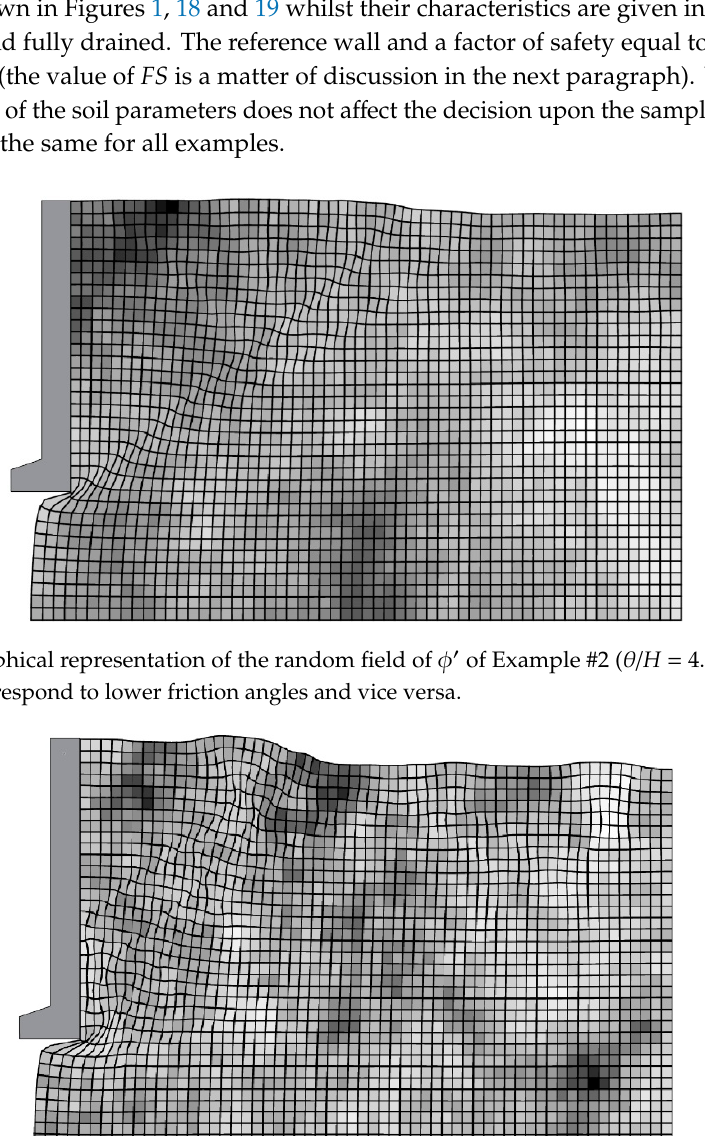
Figure 19. Graphical representation of the random field of φ (cid:48) of Example #3 ( θ / H = 0.42; see Table 1). Light areas correspond to lower friction angles and vice versa.